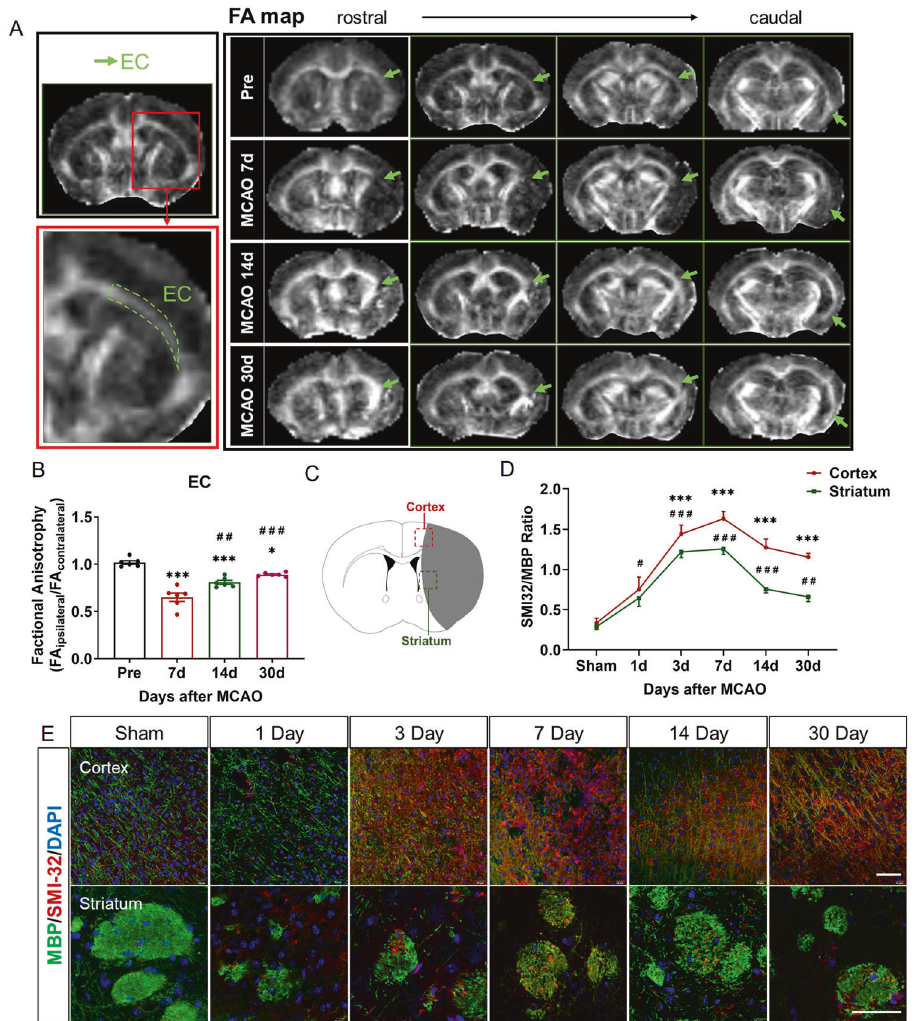
Fig. 1 White matter injury recovered gradually from Day 7 after tMCAO. A Representative DTI axial views of the same mouse brain pre- tMCAO and on the 7, 14, and 30 Day post-tMCAO. Green arrowheads pointed EC. B Quanti fi cation of FA value expressed as the ratio of ipsilateral values to the contralateral values. n = 6. * p < 0.05 and *** p < 0.001 versus Pre-tMCAO group, ## p < 0.01 and ### p < 0.001 versus tMCAO 7 Day group. C Schematic diagram of the observation position on the cortex and the striatum of brain slices after tMCAO or sham operation. D The ratios of SMI32 to MBP staining intensity in the ipsilateral cortex and striatum chronologically. n = 6. *** p < 0.001 compared to sham group in the cortex, # p < 0.05, ## p < 0.01, and ### p < 0.001 compared to sham group in the striatum. E Immuno fl uorescence staining of SMI32 (red) and MBP (green) in the cortex and the striatum area of sham or 1st, 3rd, 7th, 14th, 30th Day after tMCAO. Scale bars, 20 μ m. For all error bars ( B , D ), mean values ±